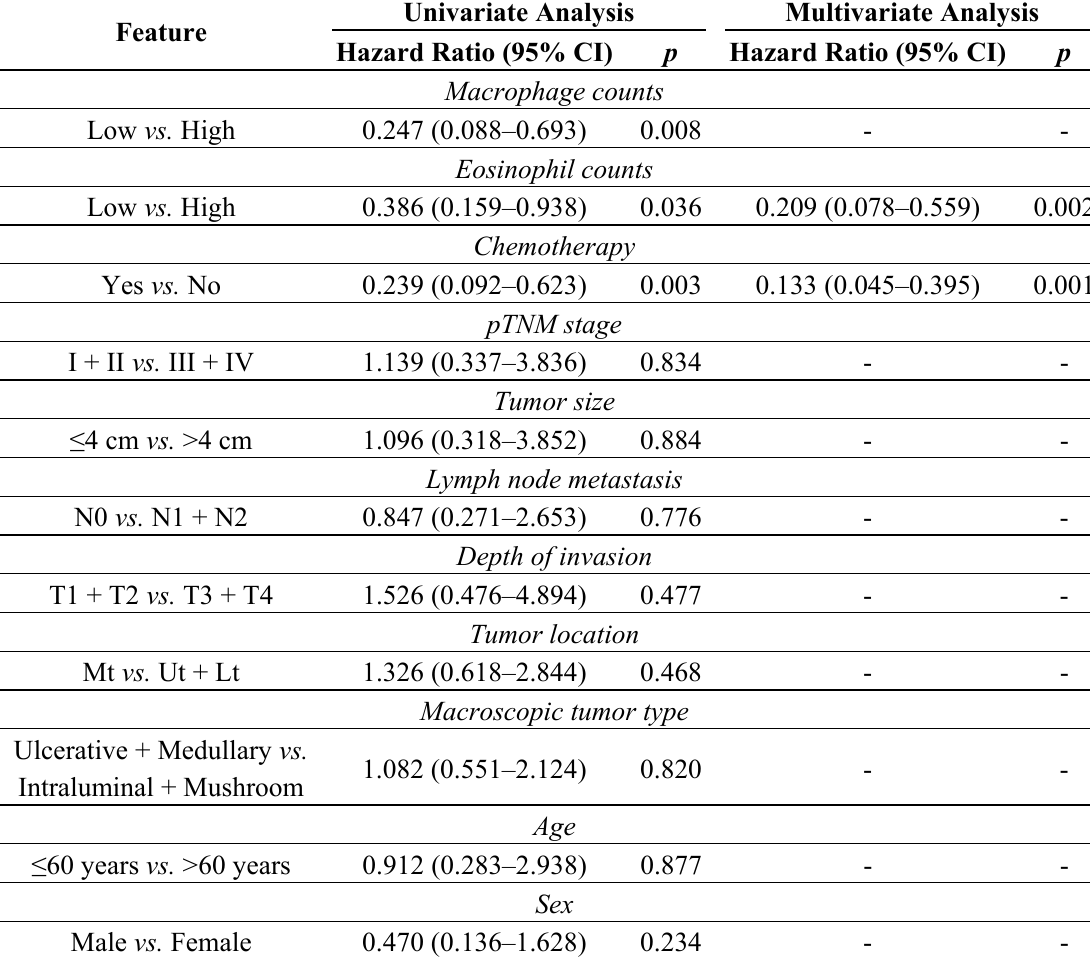
Abbreviations: CI, confidence